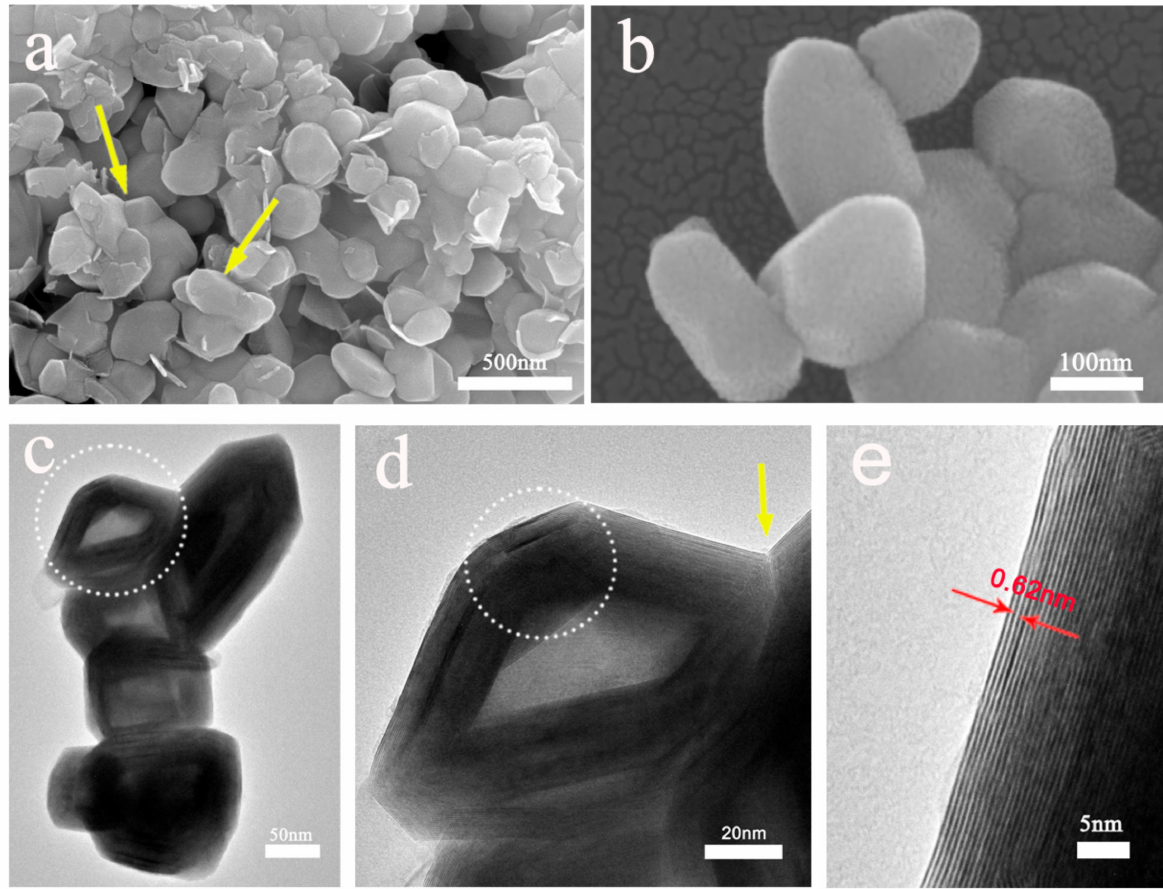
Figure 2. ( a , b ) The Scanning Electron Microscope (SEM) and ( c – e ) Transmission Electron Microscopy (TEM) images of IF–WS 2